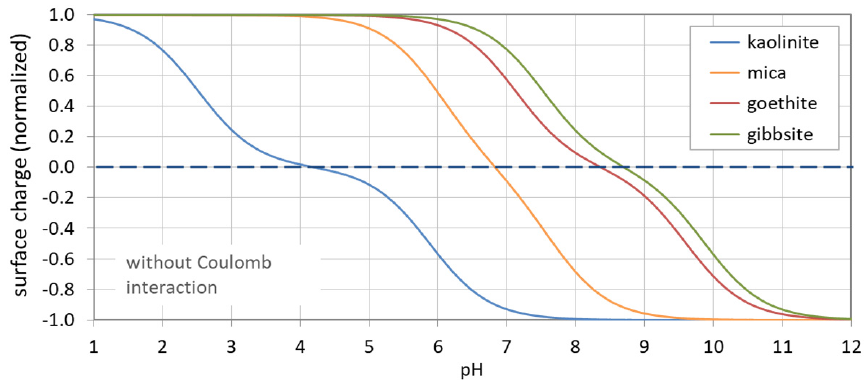
Figure 43. pH dependence of surface charge for four surfaces (in the absence of Coulomb interac- tions).